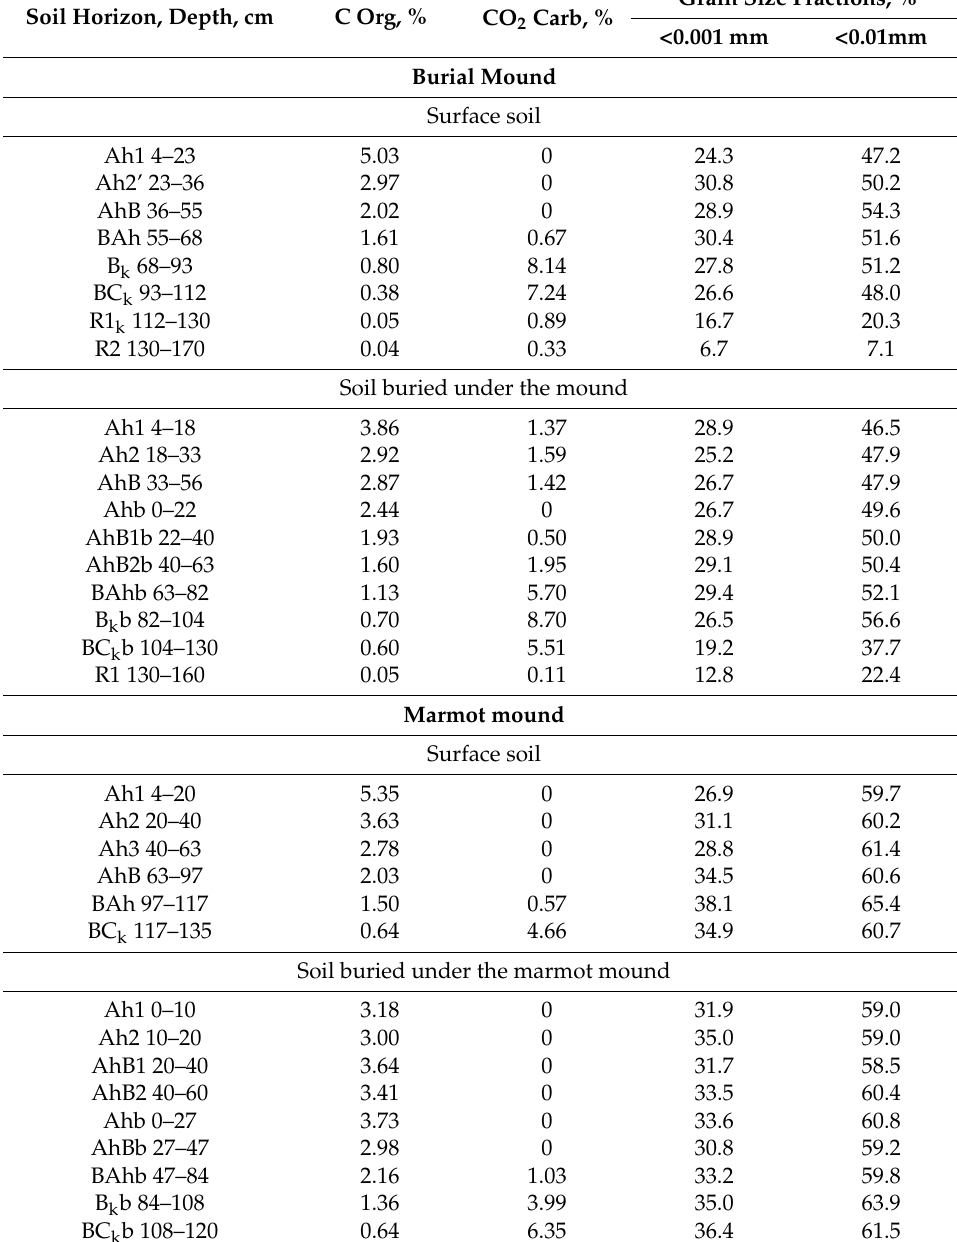
Table 3. Some physical, physicochemical and chemical properties of the studied